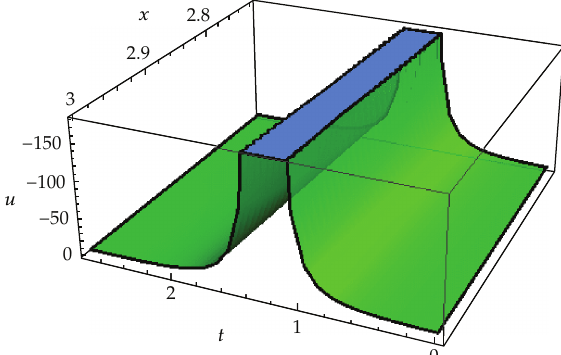
Figure 1: Evolution of travelling wave solution (14) with parameters 𝑦 = 0, 𝜌 = 0.42 .